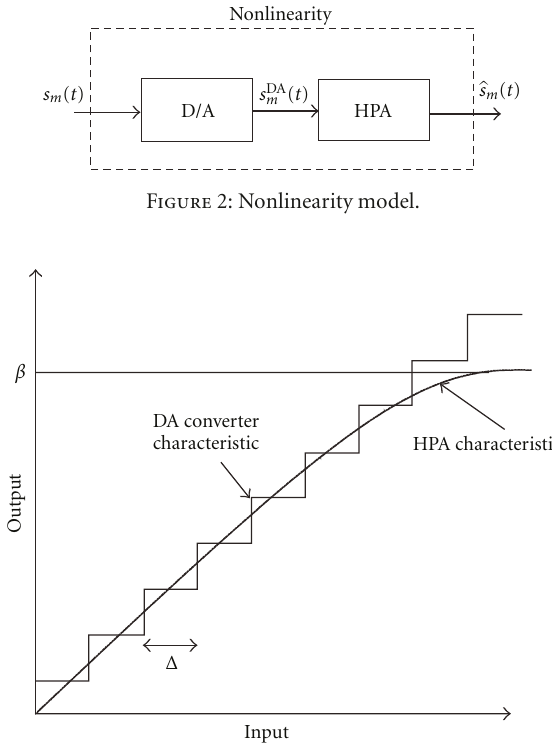
Figure 2: Nonlinearity model.